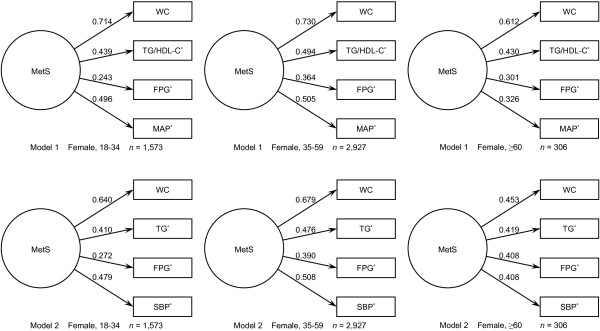
Two single-factor models for MetS for women in different age groups. Abbreviations: MetS, metabolic syndrome; WC, waist circumference; TG/HDL-C, the ratio between triglyceride and high-density lipoprotein cholesterol; FPG, fasting plasma glucose; MAP, mean arterial pressure; TG, triglyceride; SBP, systolic blood pressure. Models are grouped in different age ranges in both sexes. Values with asterisk (*) were loge transformed in CFA.